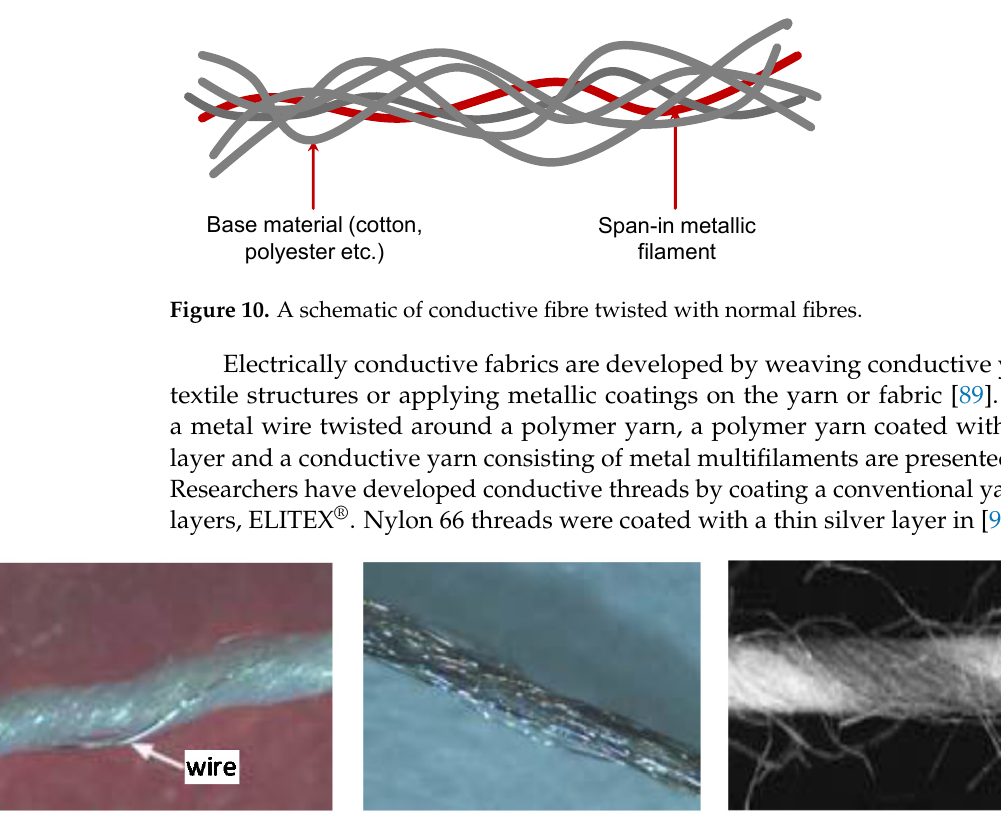
Figure 11. ( a ) A metal wire is twisted around a polymer yarn; ( b ) a polymer yarn coated with a thin metal layer; and ( c ) a conductive yarn made of metal multifilaments (adapted from [89]).